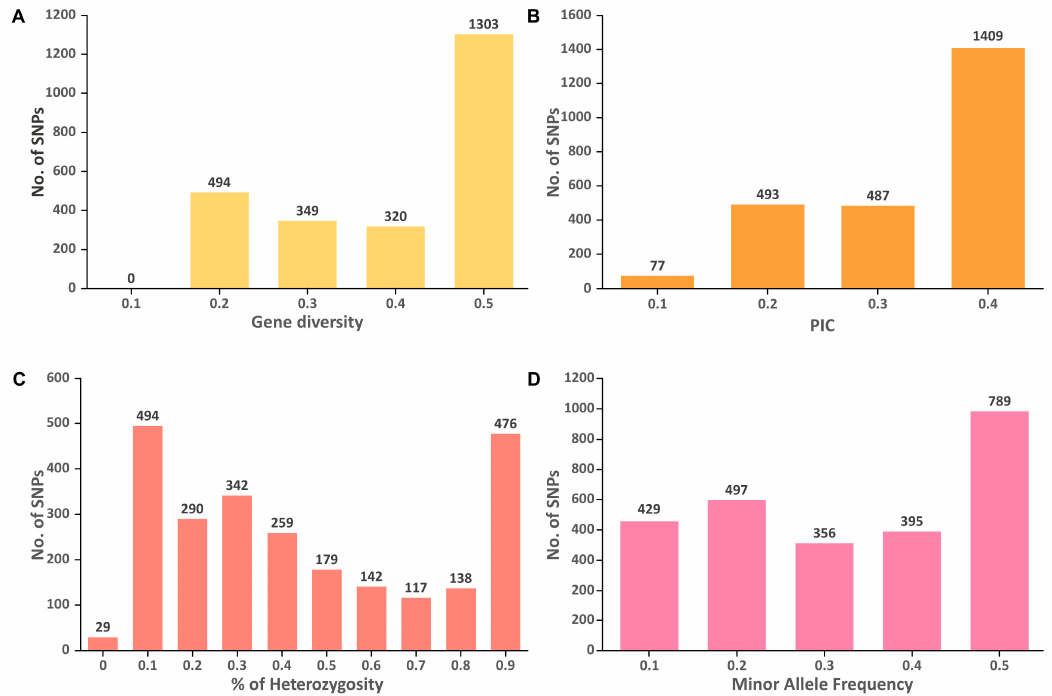
Figure 4. Population structure and genetic diversity of M. speciosa. ( A ) Population structure of 85 M. speciosa accessions. Each accession is represented by a vertical bar, and the length of each color re- flects the proportion contributed by ancestral populations. Accessions collected in Western and Southern Thailand are indicated by red dots while those collected in Central Thailand are indicated by grey dots. ( B ) Principal component analysis (PCA) of 85 M. speciosa accessions based on 2492 SNP markers. Each accession is represented by a single dot with colors indicating subpopulations.